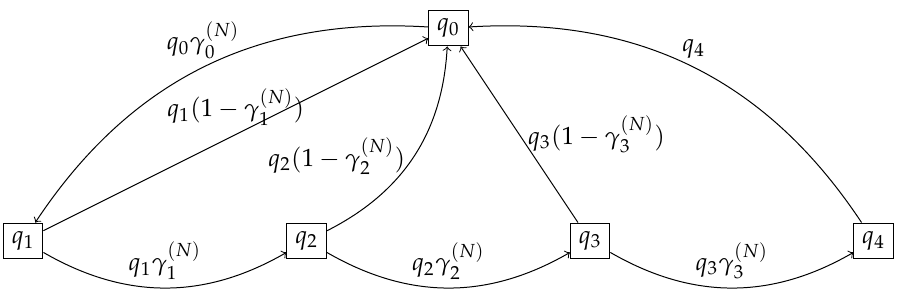
Figure 2. Example of the dynamics of the 802.11 model with D =